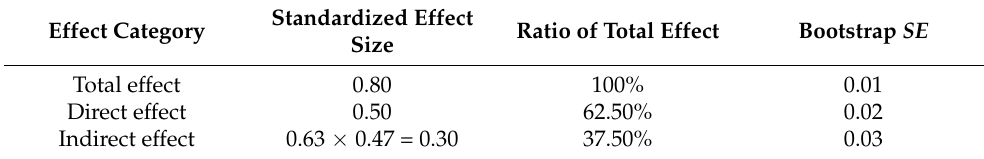
Table 5. Decomposition of path effect of subjective exercise experience on exercise behavior.